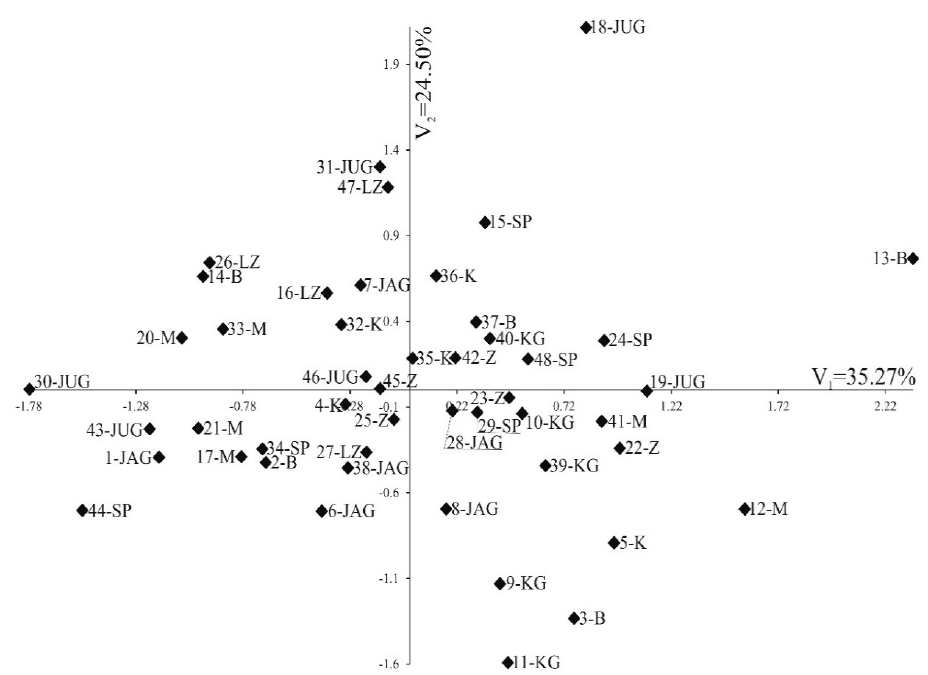
Figure 11. Distribution of 48 Abies alba genotypes in the space of the first two canonical variables. The coordinates of the point for particular genotypes are values of the first and second canonical variables, respectively. Numbers from 1 to 48, see Table 1.